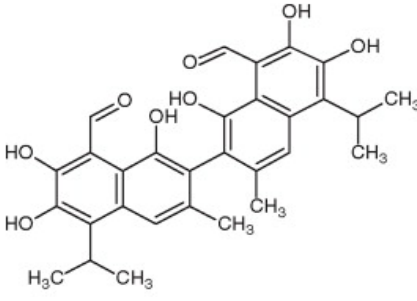
Figure 1. Chemical structure of